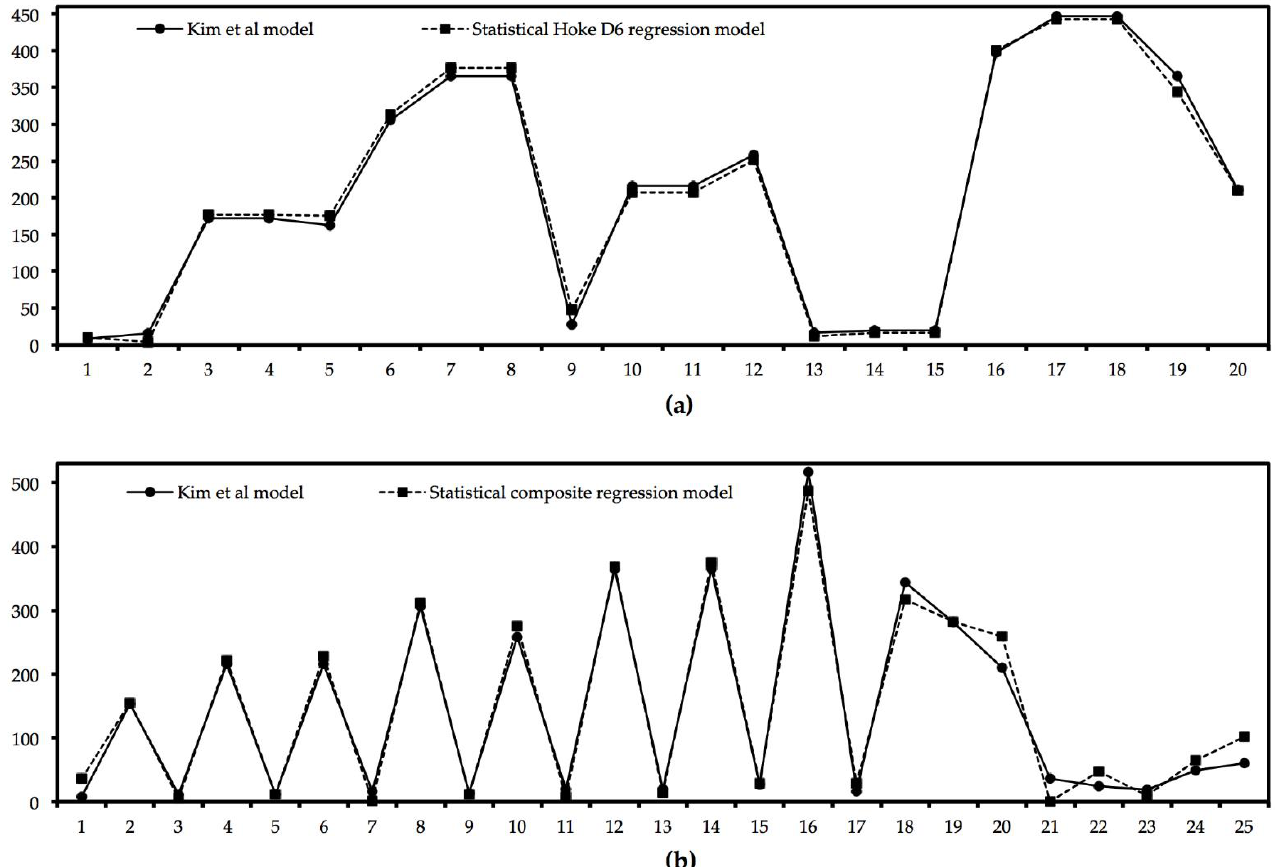
Figure 1. Test dataset comparison. Both DOE methods provided models with satisfactory data trends and good fit to absolute location for the test datasets. ( a ) Outputs of Hoke D6 design model compared to those of Kim et al. ’s model [28]; ( b ) outputs of composite factorial regression model compared to those of Kim et al. ’s model [28]. y axis — b in Ws 1/2 m −2 K; x axis — the number of the tested scenario.